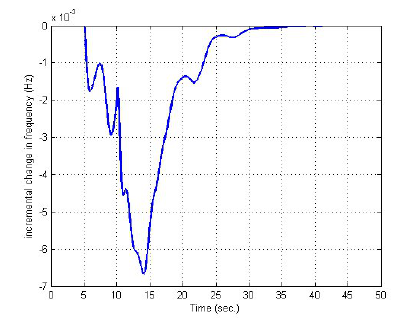
Fig. 9: Tie-line power deviation (Case 2)